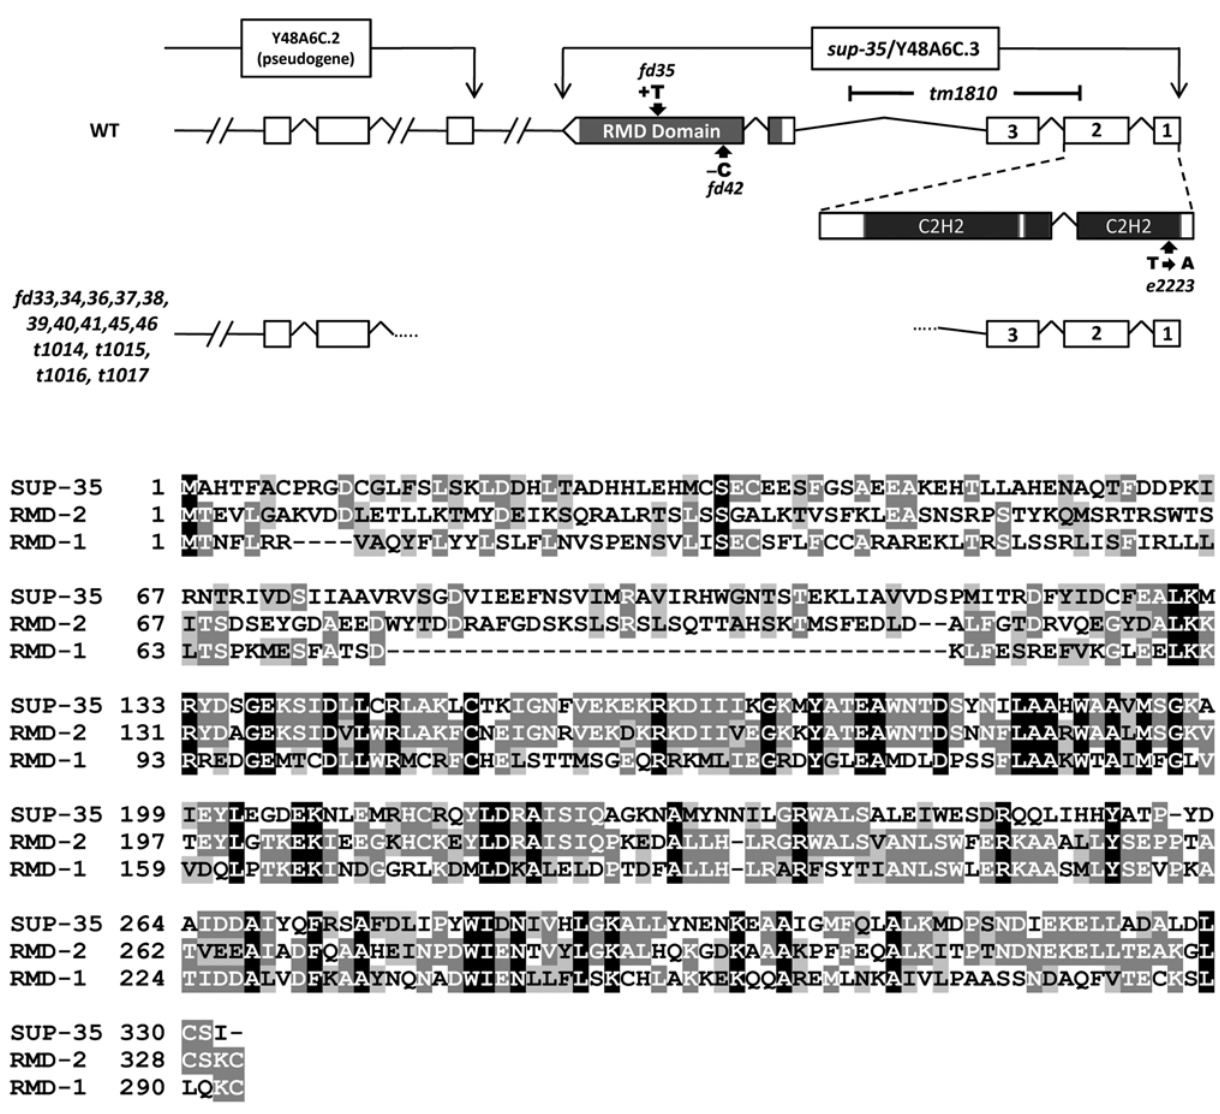
Figure 1. sup-35 genomic locus. (A) Genomic organization of sup-35 showing the locations of the two N-terminal C2H2-type Zn-finger domains and the C-terminal RMD-like domain. sup-35 alleles that contain point mutations or single nucleotide insertions or deletions are indicated by bold arrows. The large deletion alleles are represented by a gap in the gene structure; dotted lines indicate the approximate position of the deletion breakpoints as determined by PCR. The consortium generated tm1810 deletion allele is indicated by the black bracket. tm1810 deletes 741 nucleotides and leads to translational termination following amino acid 62. (B) Peptide sequence alignment showing the similarity of SUP-35 to RMD- 2 and RMD-1. Consensus amino acids are indicated by white letters with black backgrounds, identical residues by white letters with dark-gray backgrounds, and similar residues by black letters with light-gray backgrounds. Overall, SUP-35 is 37% identical to RMD-2 and 19% identical to RMD- 1. RMD-2 and RMD-1 are 30%